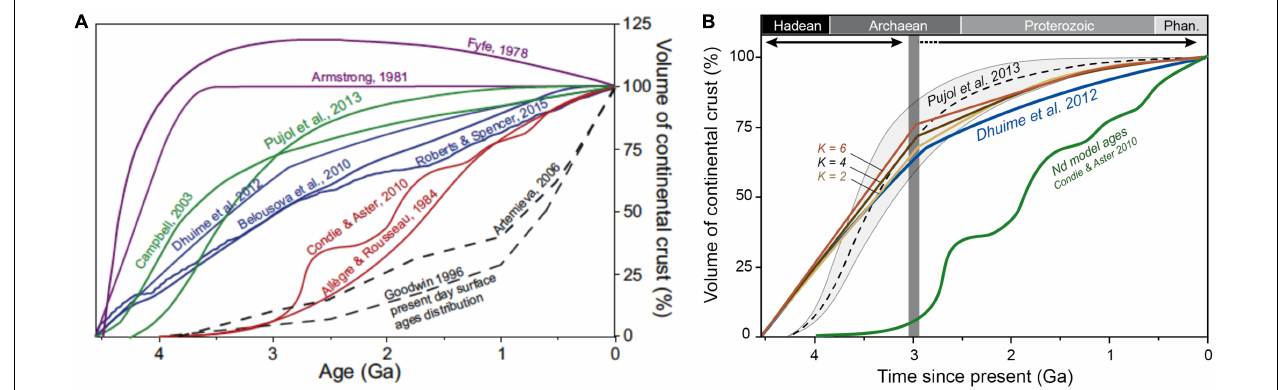
FIGURE 10 | (A) Crustal growth curves grouped into those that rely on age distributions preserved in present day geology (dashed and red curves), those that constrain the volumes of crust in the past independent of present day age distributions (dark purple and green curves), and those that invoke relative crust volumes for a theoretical reason, such as there might be more crust generated on a hotter Earth (light purple). (B) Selected crustal growth curves suggesting that 60–80% of the present volume of the continental crust had been generated by 3 Ga, compared with the present day proportions of juvenile continental crust based on zircon crystallization ages in rocks with juvenile Nd or Hf isotope ratios (Condie and Aster, 2010). These are the starting conditions for the box model illustrated in Figure 11 (Dhuime et al.,